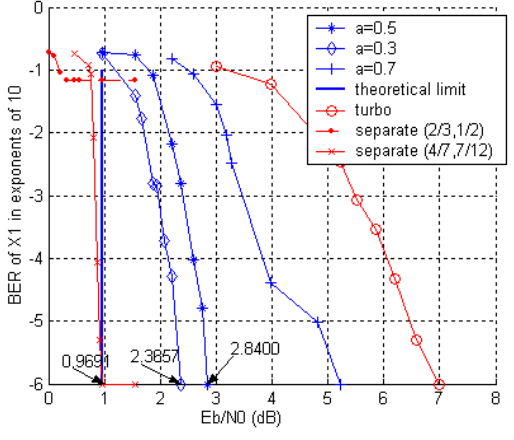
in the two sources DJSCC scheme. 1